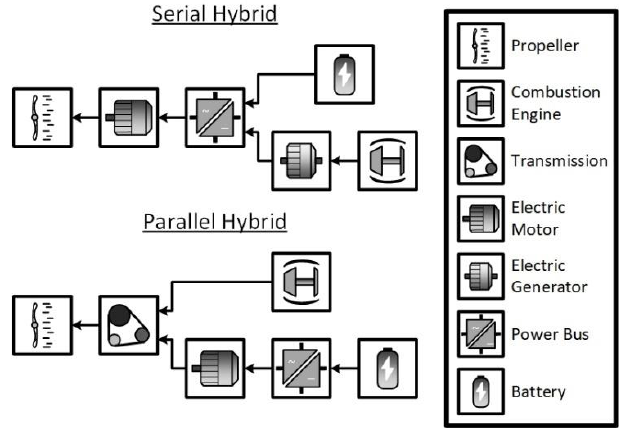
Figure 1. Depiction of serial and parallel hybrid electric system components and functionalities.